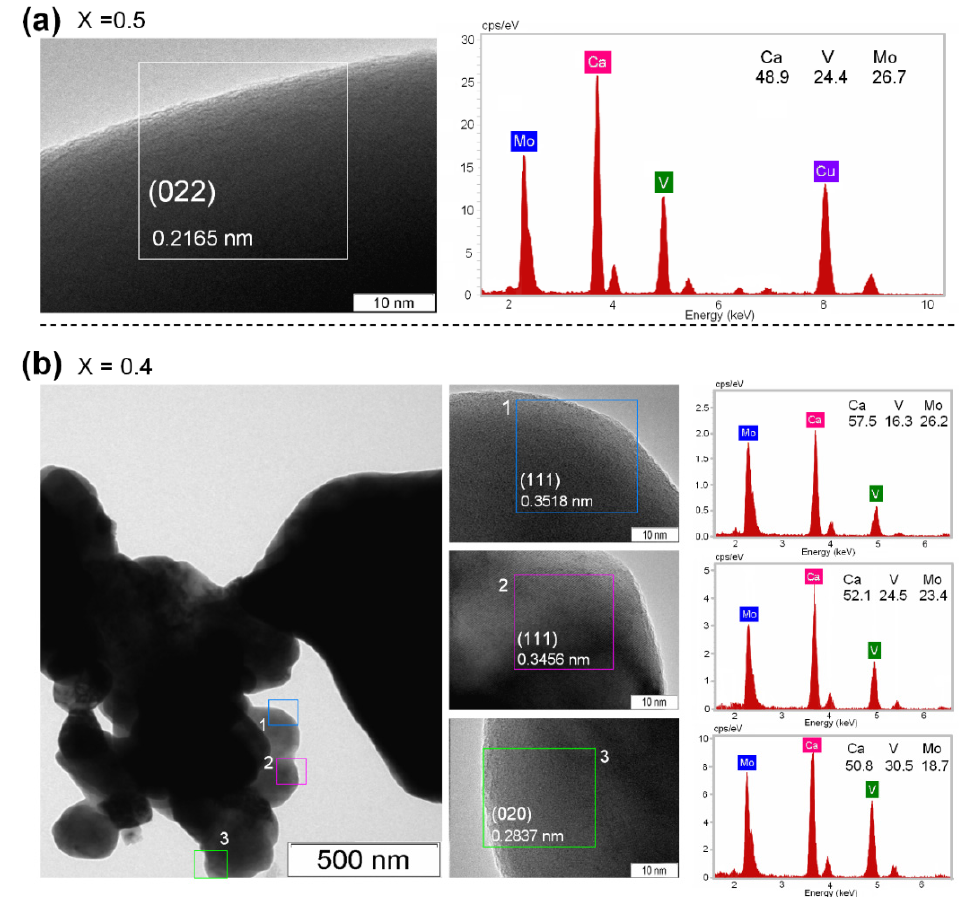
Figure 4. HRTEM images of CaV 0.5 Mo 0.5 O 3– δ ( a ) and CaV 0.6 Mo 0.4 O 3– δ ( b ) powders with results of EDX elemental analysis.